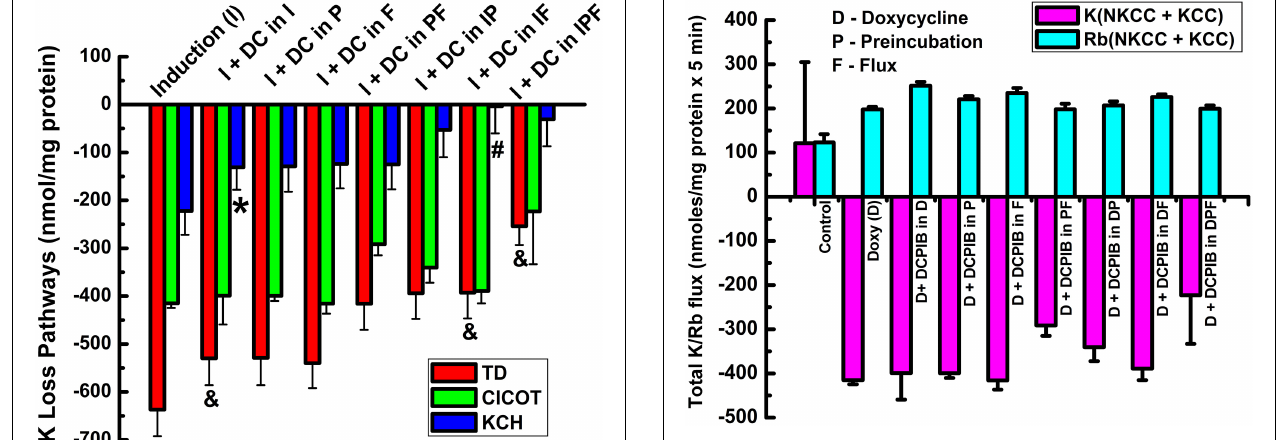
FIGURE 9 | Cl-independent K i loss trigged by constitutive KCC3 Thr991/Thr1048 dephosphorylation is DCPIB-sensitive. Bars indicate total doxycycline-induced K i loss (T, red), K i loss through Cl-dependent cotransporters (NKCC + KCC, ClCOT, green), and K + channel-sensitive K i loss (KCH, blue) when DCPIB, an inhibitor of volume regulated Cl − channels (VRACs) and intermediate K + channels, was applied in the induction (I), preincubation (P), and/or flux (F) stages of the ion flux study. DCPIB inhibits Cl-sensitive K i loss. Representative results from a typical experiment done in quadruplicates. Total number of similar experiments, N = 4 . For T, there was a statistically significant difference between groups as determined by One-Way ANOVA [ F (7 , 24) = 5 . 15 , p < 0 . 001 , n = 32 ] or by Kruskal–Wallis One-Way ANOVA [ F (7 , 24) = 4 . 46 , p < 0 . 005 , n = 32 ]. There was a statistically significant difference between groups as determined by Kruskal–Wallis One-Way ANOVA